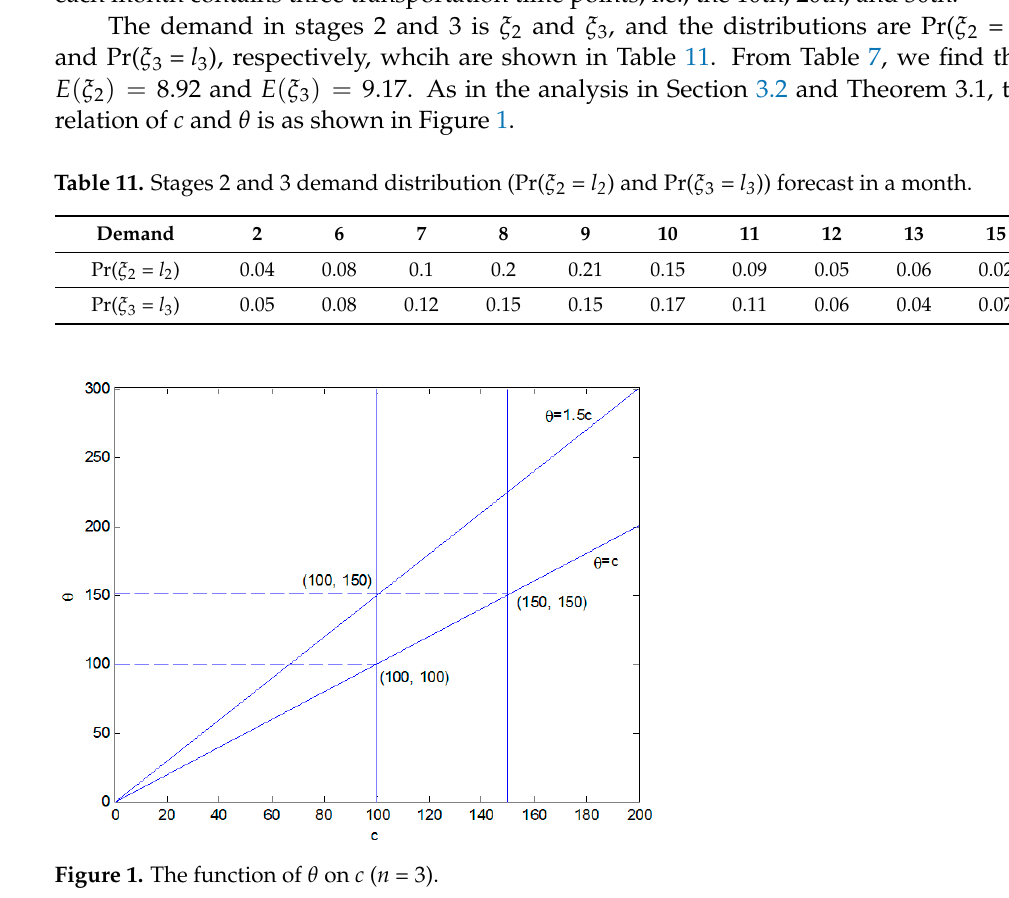
Table 12. The GEM solutions ( n = 3).